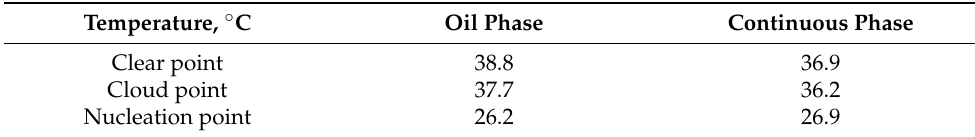
Table 2. The behavior of two liquid phases under